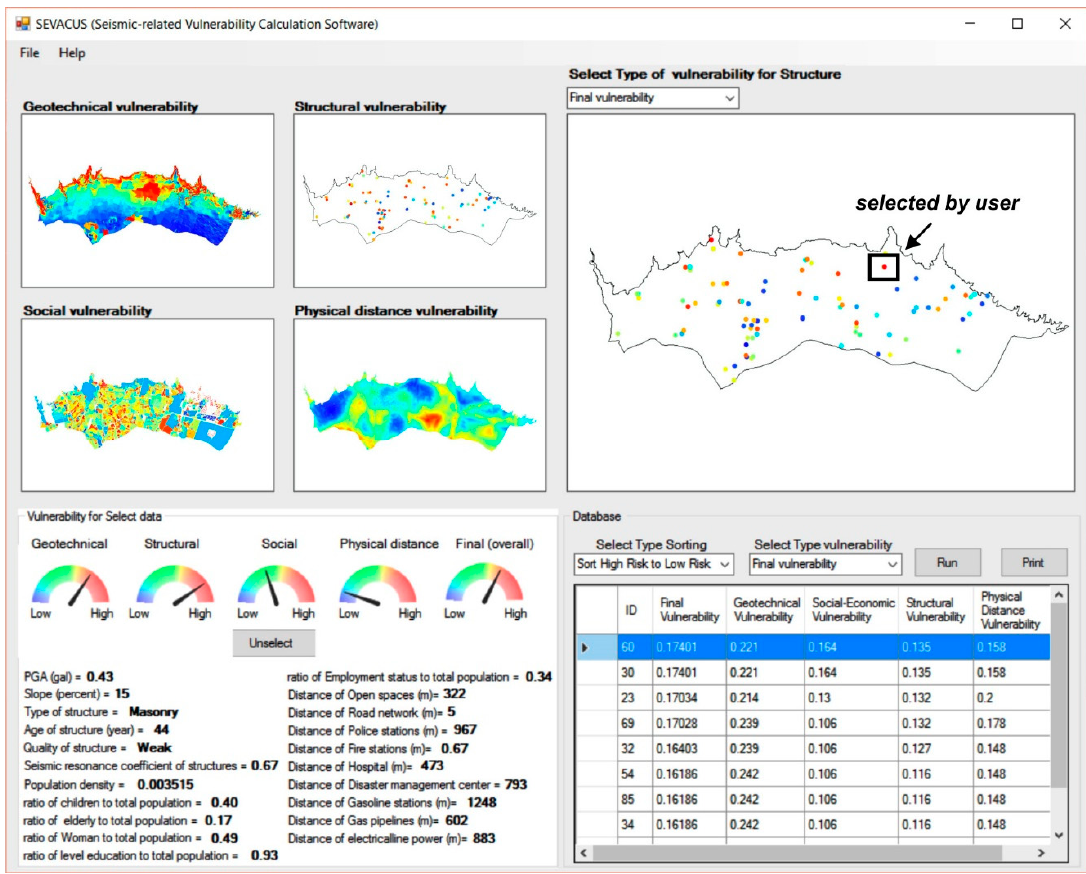
Figure 7. A view of output tab of SEVACUS.